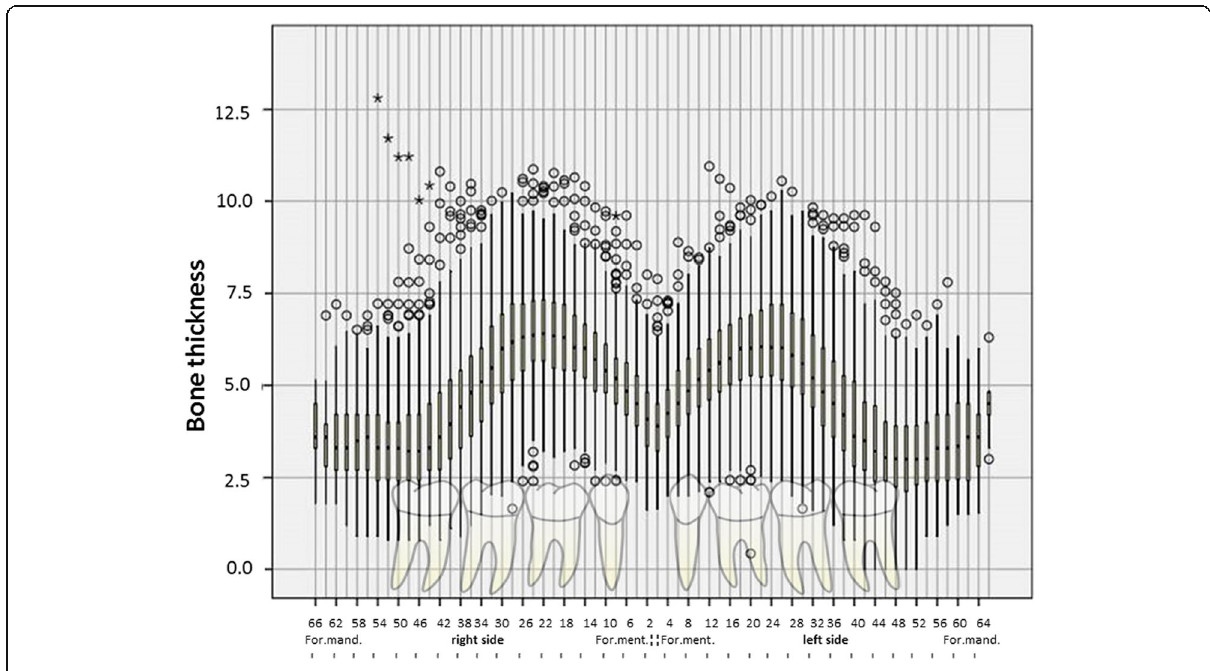
between the lateral wall of the mandibular canal and the buccal border of the mandibular cortical plate and the position of the mental foramen in relation to the neigh- bouring teeth. The findings were evaluated for men and women and different age groups, and both sides of the mandible were compared.